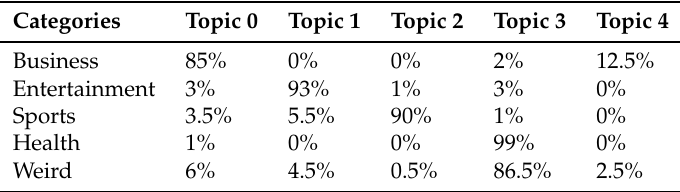
Table 4. Performance of NMF in labeling documents by using Topic.